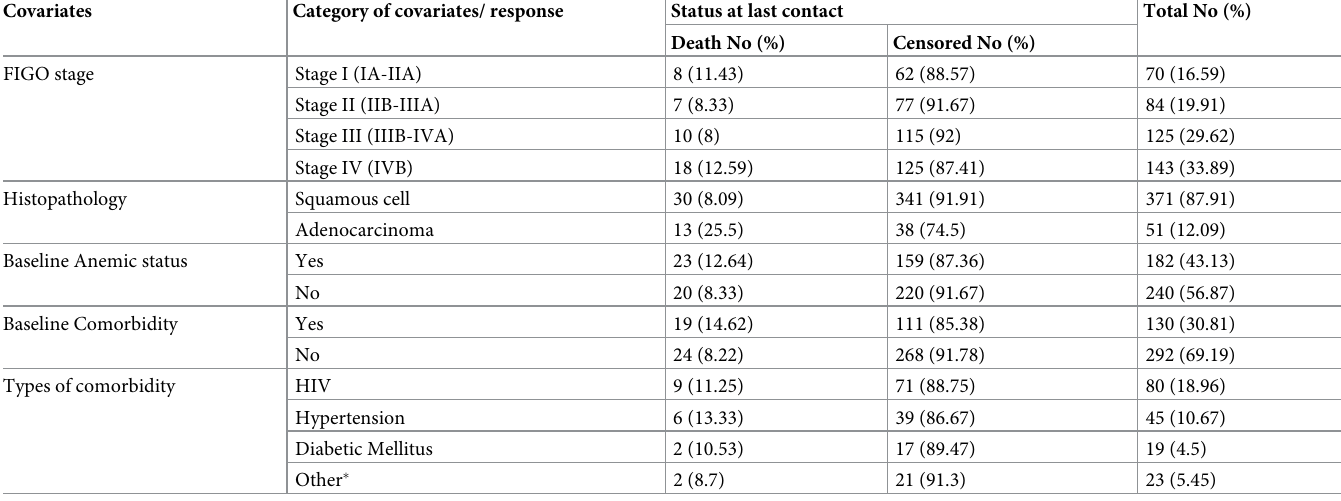
Table 3. Clinical and histopathological characteristics of cervical cancer patients in Felege Hiwot Comprehensive Specialized Hospital Oncology Center, Ethiopia (N = 422, March 2021).